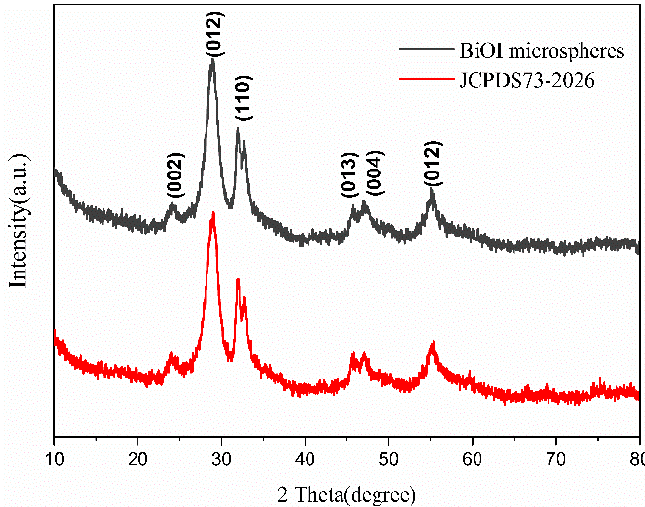
Figure 13. X-ray diffraction patterns of prepared BiOI powder.